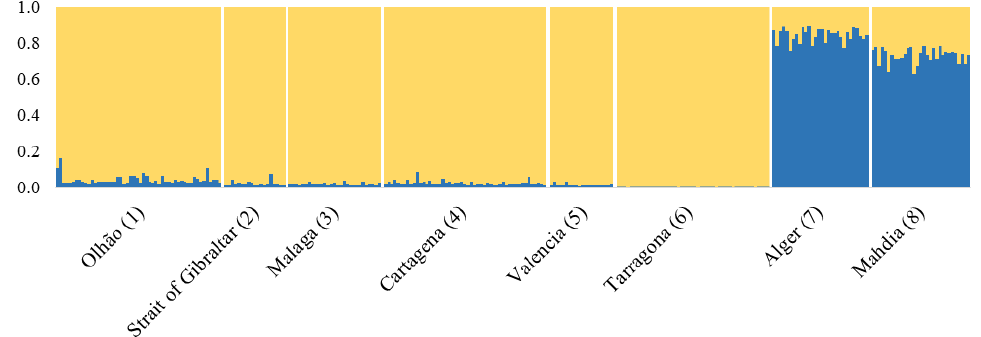
Figure 3. Population structure analysis for 7 microsatellite loci. Each individual is represented by a vertical bar where colour pattern indicates the genotypic cluster/s that are associated. Following Evanno (2005) [46] the best ‐ supported model was K = 2.